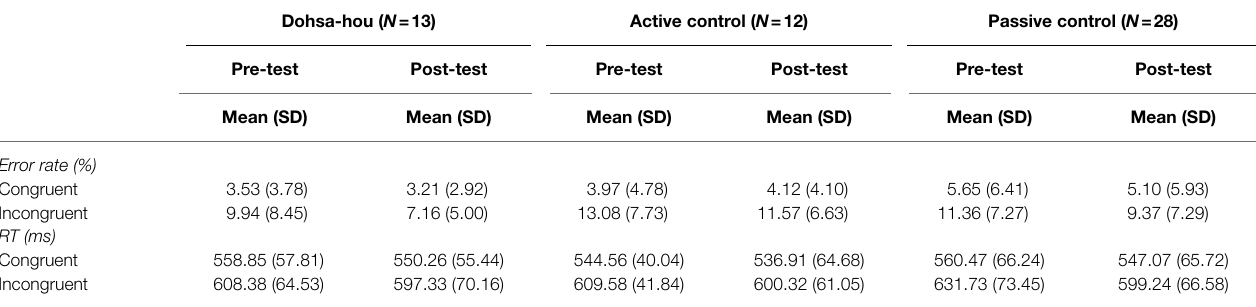
TABLE 2 | Descriptive statistics of Modified Stroop Task for the Dohsa-hou group, Active control group, and Passive control group measured at pre- and post-test. Dohsa-hou ( N = 13) Active control ( N = 12) Passive control ( N = 28) Pre-test Post-test